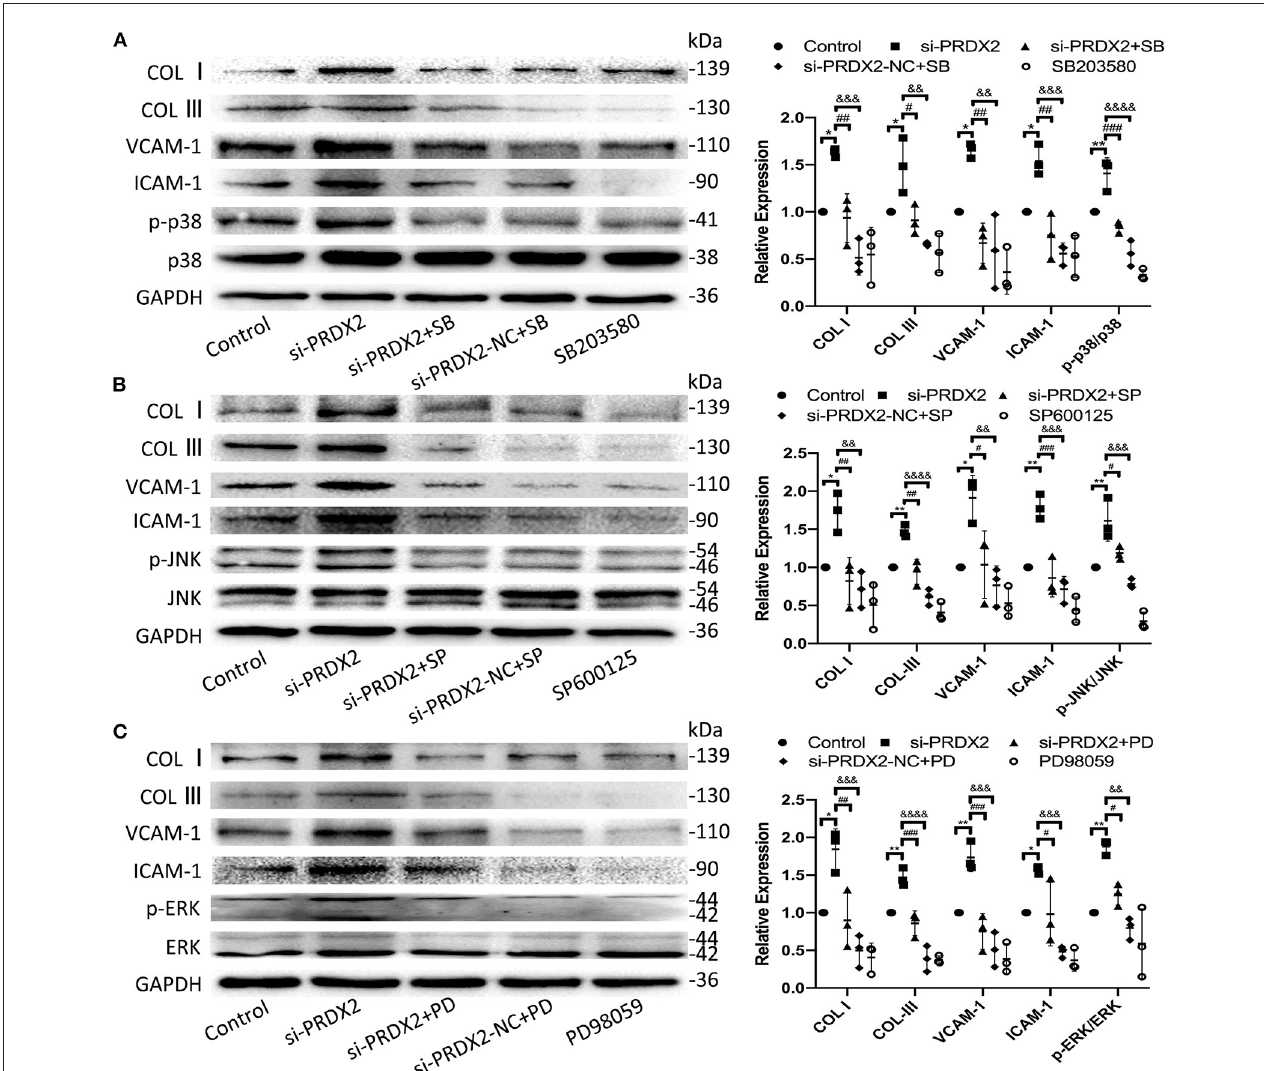
FIGURE 6 | Down-regulation of PRDX2 promotes the potential role of AS by activating the MAPK signaling pathway. (A) COL I, COL III, VCAM-1, ICAM-1, and p-p38 protein expression was determined by Western blot in the CAVSMCs treated with SB203580 (* p < 0.05 and ** p < 0.01 vs. control group, # p < 0.05, ## p < 0.01, and ### p < 0.001 vs. si-PRDX2 + SB group, && p < 0.01, &&& p < 0.001, and &&&& p < 0.0001 vs. si-PRDX2-NC + SB group). (B) COL I, COL III, VCAM-1, ICAM-1, and p-JNK protein expression was determined by Western blot in the CAVSMCs treated with SP600125 (* p < 0.05 and ** p < 0.01 vs. control group, # p < 0.05, ## p < 0.01, and ### p < 0.001 si-PRDX2 + SP group, && p < 0.01, &&& p < 0.001, and &&&& p < 0.0001 vs. si-PRDX2-NC + SP group). (C) COL I,